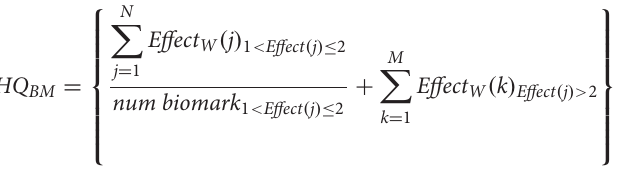
glutathione S-transferases, glutathione peroxidases,